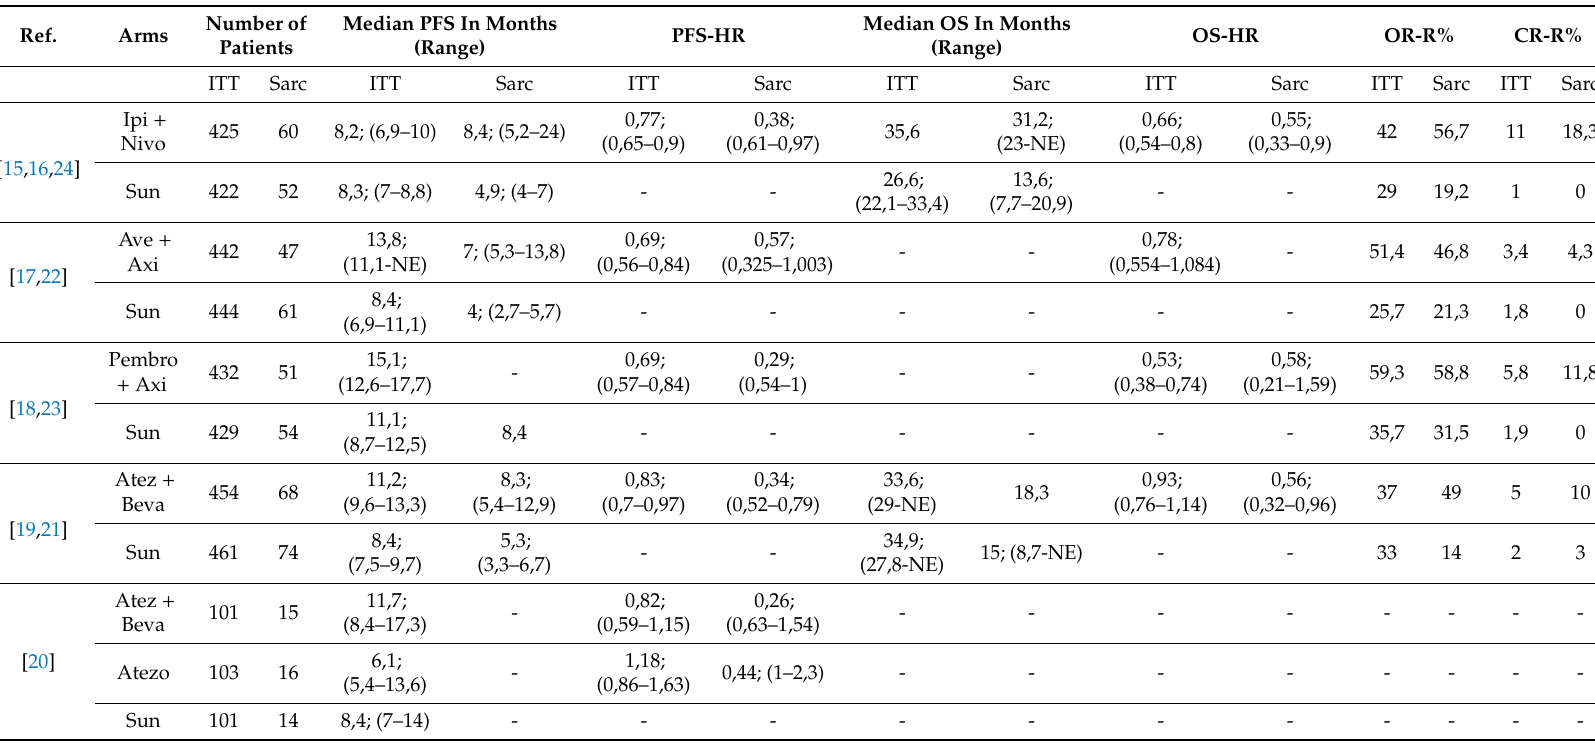
Table 1. Main characteristics of the trials included. Ipi = Ipilimumab; Nivo = Nivolumab; Sun = Sunitinib; Ave = Avelumab; Axi = Axitinib; Atez = Atezolizumab; Beva = bevacizumab; Pembro = pembrolizumab; Sun = sunitinib.